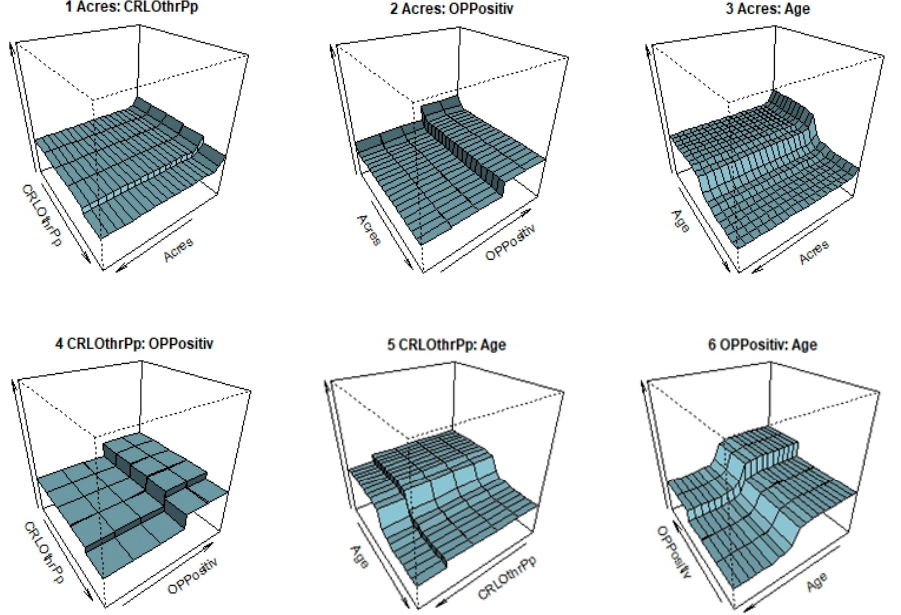
Figure 8. Interaction of variables for the willingness to rent model.